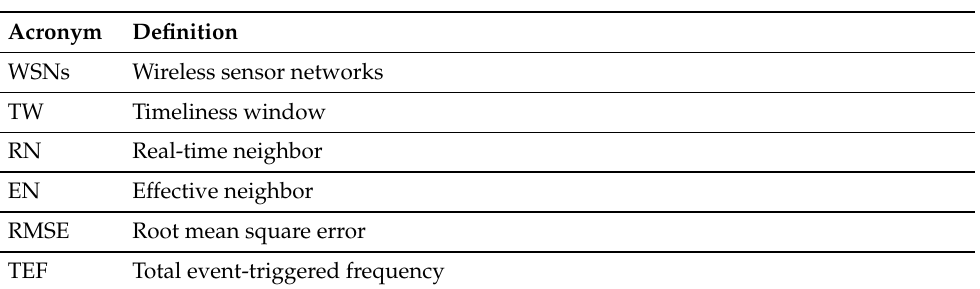
Table 2. List of abbreviations.